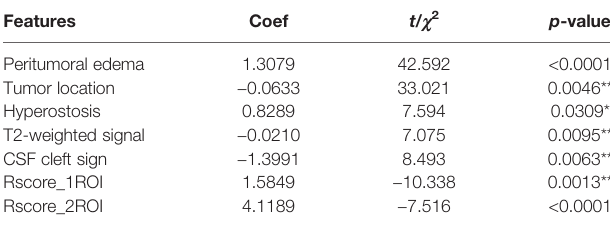
TABLE 4 | The result of multiple logistic regression.